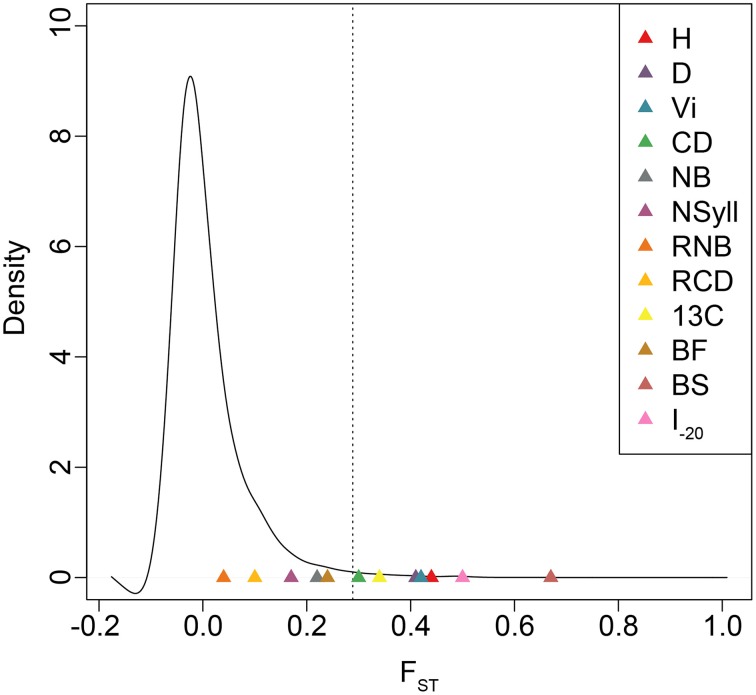
Empirical distribution of FST based on 727,993 SNPs. Dotted lines indicate the 99th percentile of FST values. QST estimates for each trait are indicated with colored triangles.